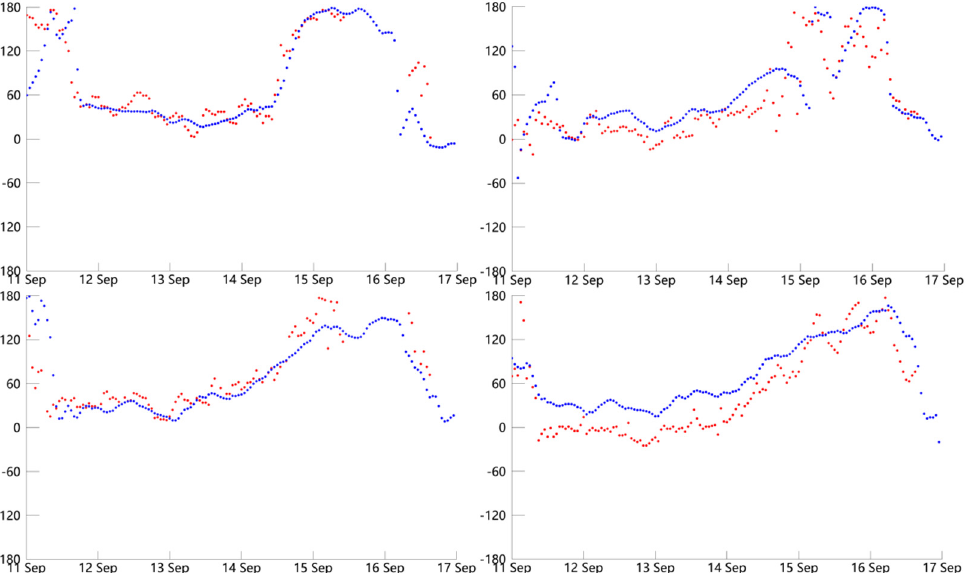
Figure 8. The temporal distributions of wind directions (degree) obtained from experiment 23 (blue dot) and buoy observations (red dot) during typhoon Dujuan at the locations of four buoys.